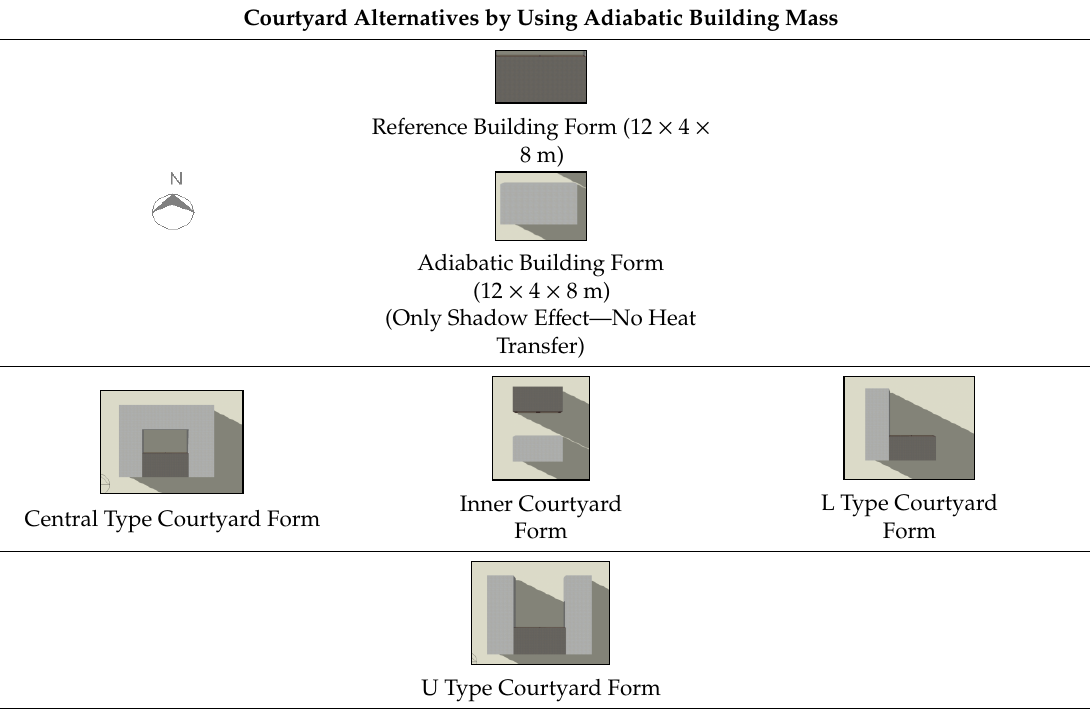
Table 6. Courtyard alternatives by using adiabatic building mass.